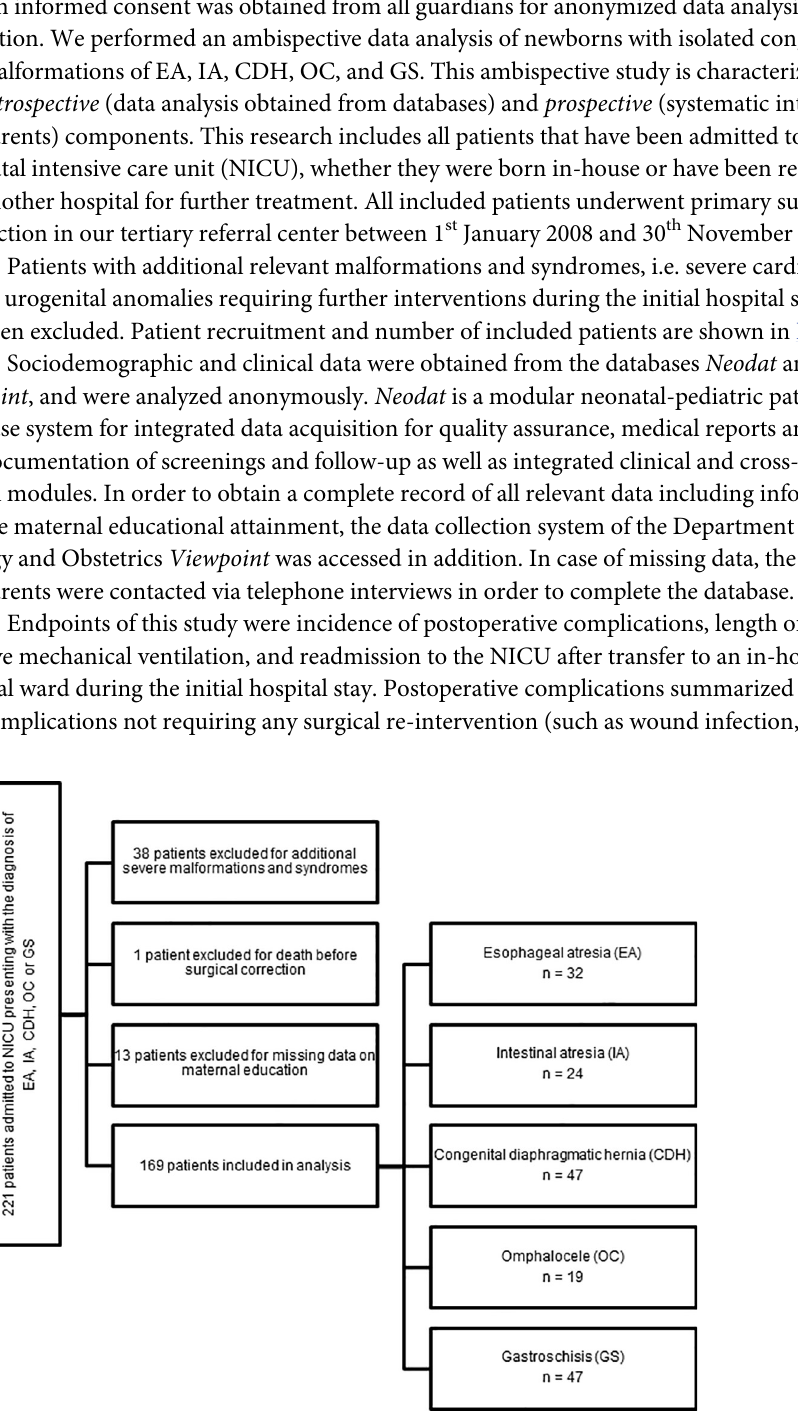
Fig 1. Flow diagram of patient recruitment and number of included patients between 01/2008 and